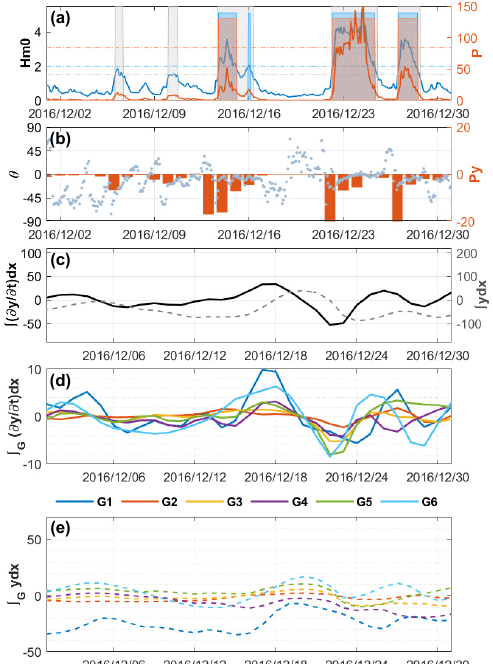
Figure 12. Changes in wave and beach parameters during December 2016. ( a ) Significant wave height and wave power, ( b ) wave direction and longshore component of wave power, ( c ) longshore transport rate (solid line) and integrated beach width (dashed line), ( d ) longshore transport rate for each sector, and ( e ) integrated beach width for each sector. Under milder wave conditions, rapid and significant changes in beach width did not occur.